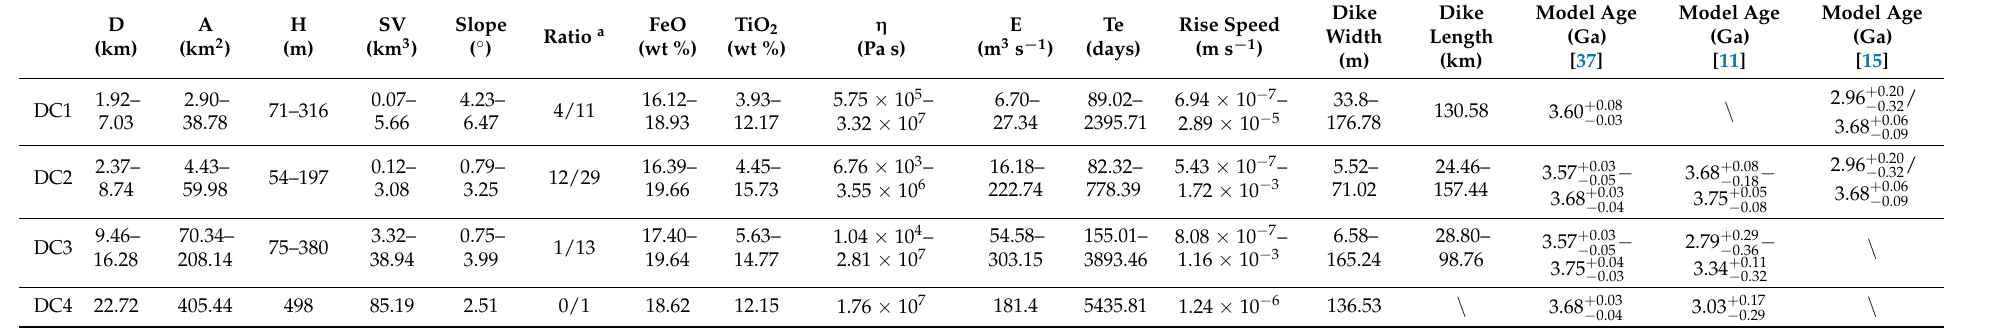
Table 3. Statistical range of the 14 parameters and ages for the four